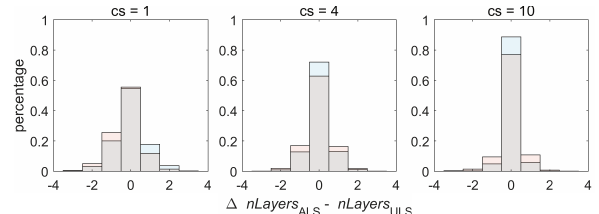
Figure 7. Relative histograms of differences between nLayers calculated from ULS data with regard to ALS data for raster cell sizes ( cs ) of 1, 4, and 10 m, respectively. Bin widths are set to 1, corresponding to one layer. Orange: site 1, blue: site 2, gray: overlay of the